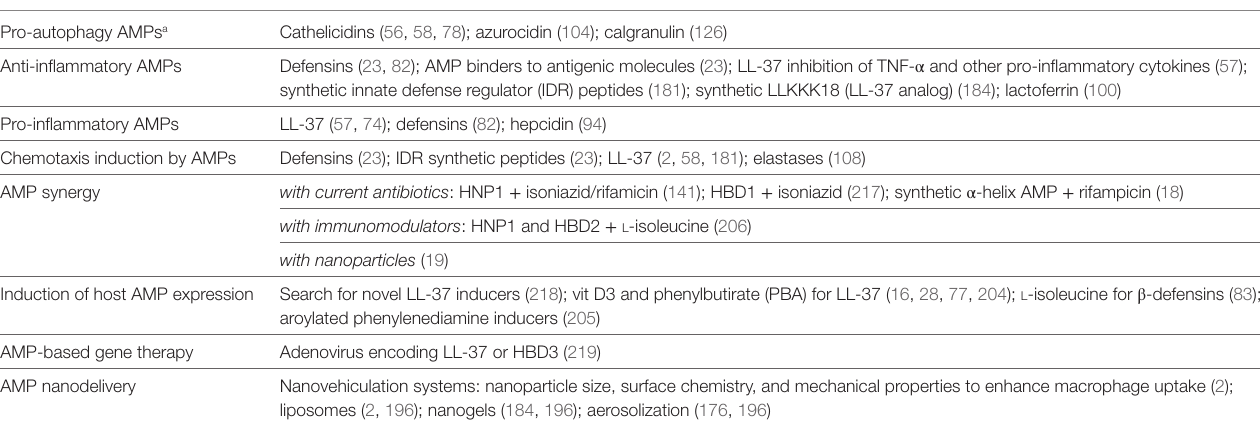
TABLe 3 | AMPs based strategies to develop novel anti-TB drugs. Pro-autophagy AMPs